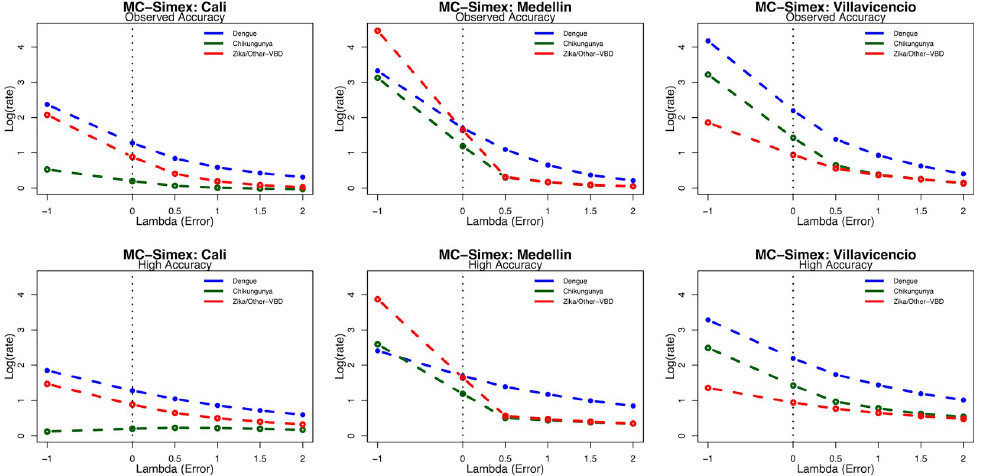
Fig 3. Simulation Extrapolation results: Measurement Error estimation of the reporting by disease, adjusted by age and year of reporting in Cali, Medellin, and Villavicencio (Colombia) 2014–2017. The estimated rates on the log scale are presented on the Y axis and the degree/change of misclassification error (Lambda) on the X axis. The dotted line at error level zero in the X axis indicates the observed rates (i.e: uncorrected rates, Table 3) and the estimates at the error level -1, indicates the extrapolated (corrected) rates accounting for the misclassification error. Estimates from error level 0.5 to error level 2, indicate the change in the estimated rates of reporting by adding different levels of misclassification error. Top: results using the observed values of accuracy (sensitivity) for the diagnosis. Bottom: results assuming high accuracy (90% correctly identified) of the clinical diagnosis. Other VBD refers to non-specified vector-borne diseases.